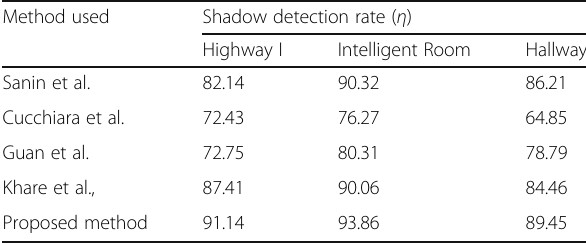
Table 1 Shadow detection rate ( η ) for representative video sequences